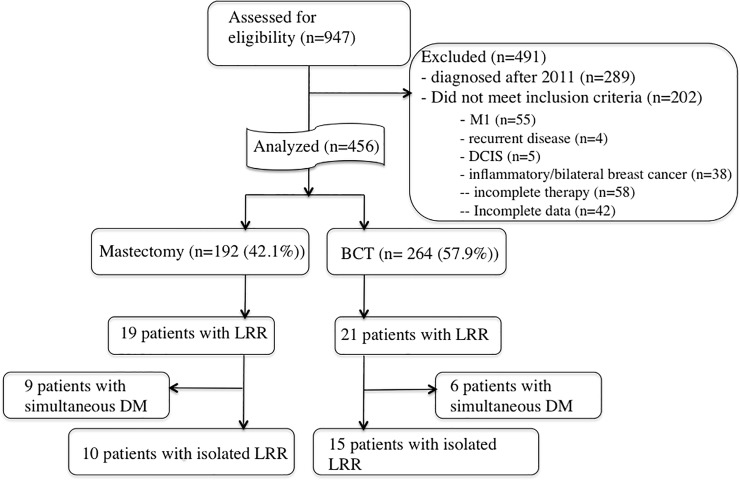
CONSORT diagram.